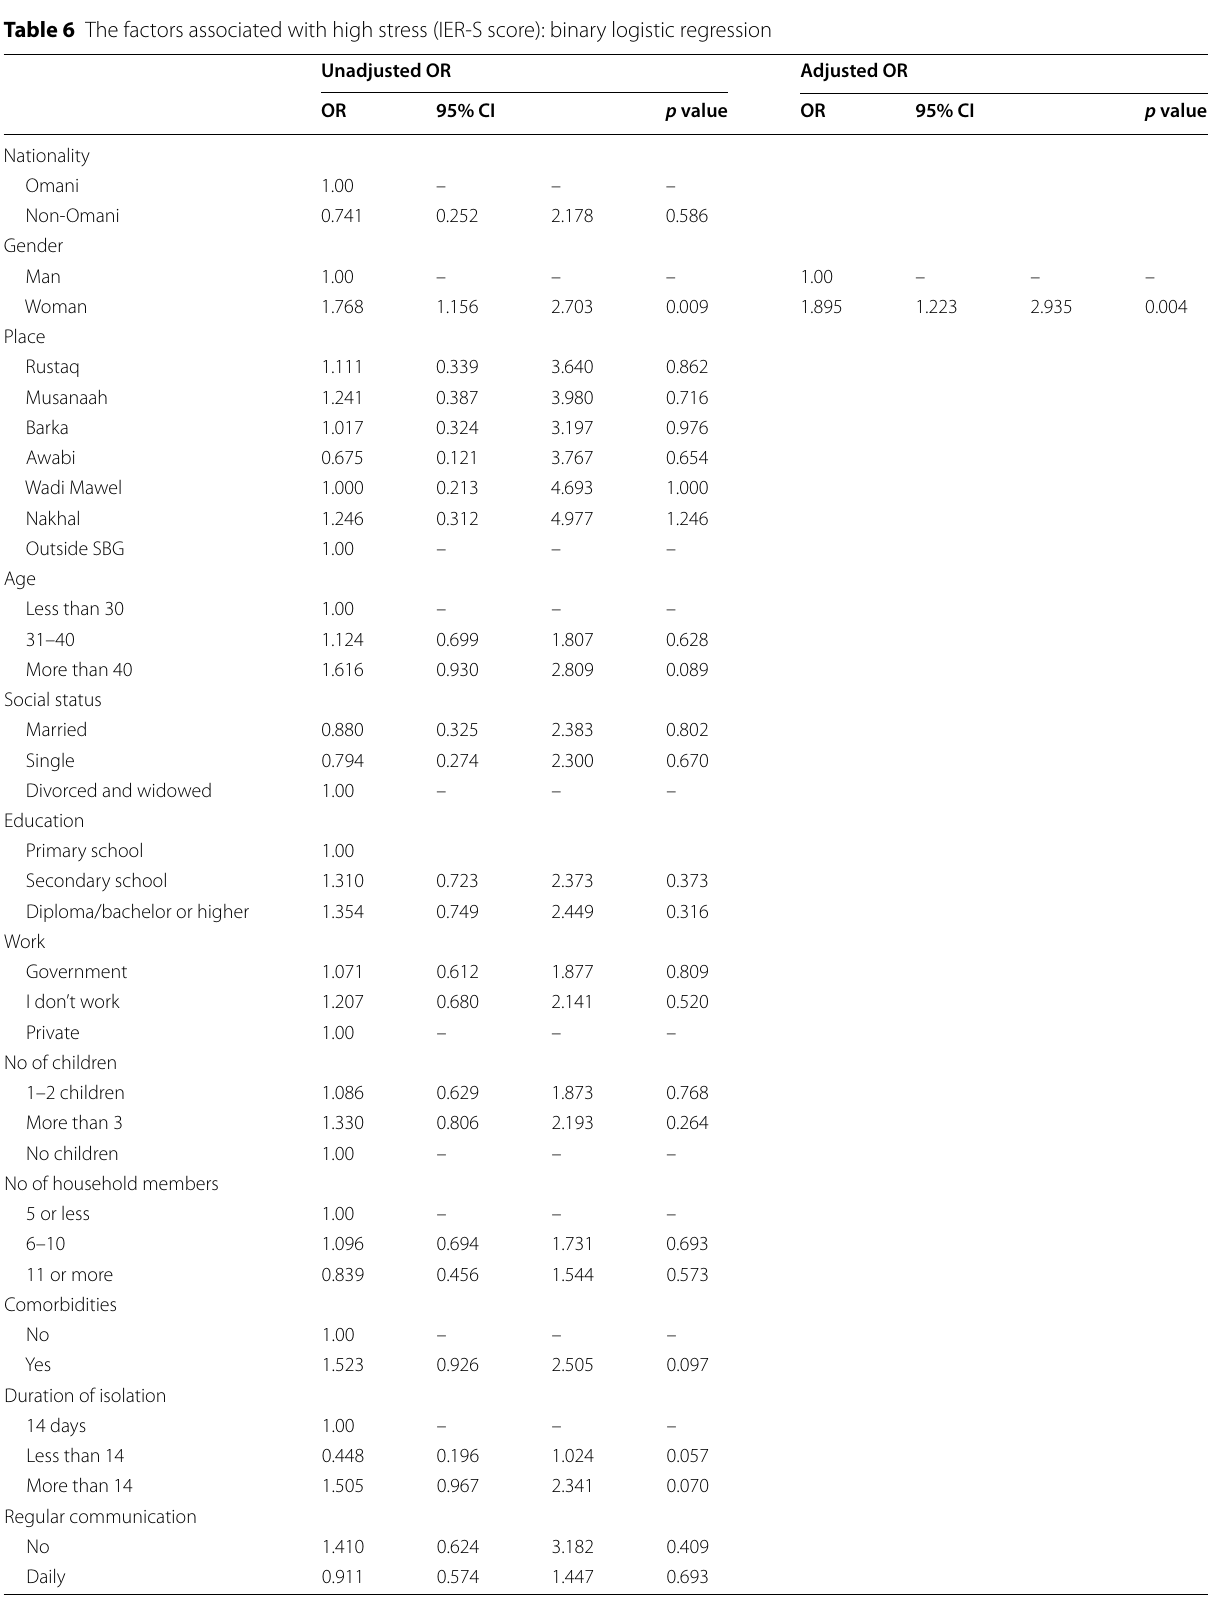
Table 6 The factors associated with high stress (IER-S score): binary logistic regression Unadjusted